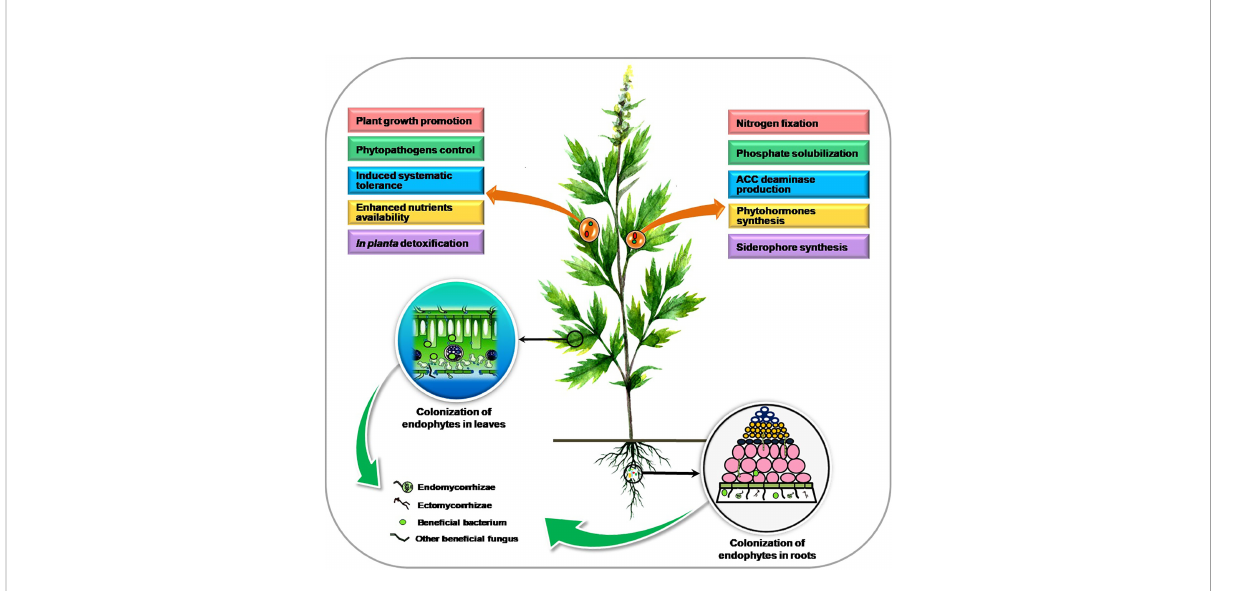
FIGURE 1 Colonization and bene fi ts of endophytic microorganisms in